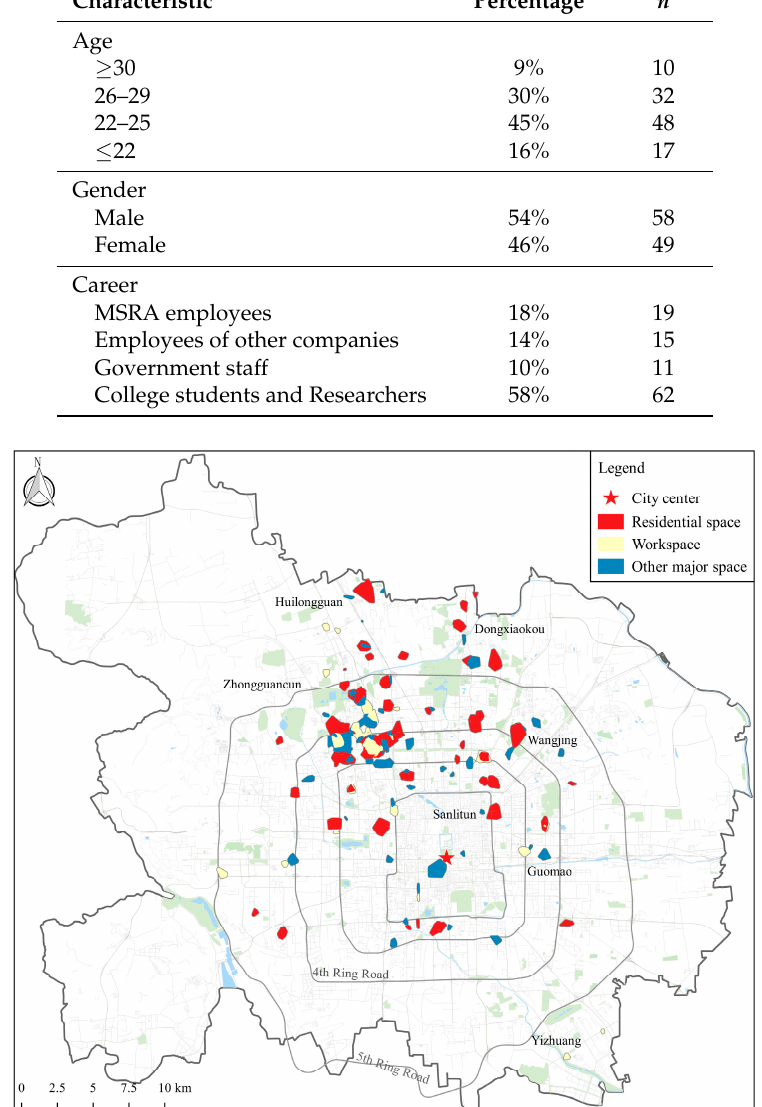
Figure 6. The aggregated distribution of the participants’ localized activity spaces ( n = 107).